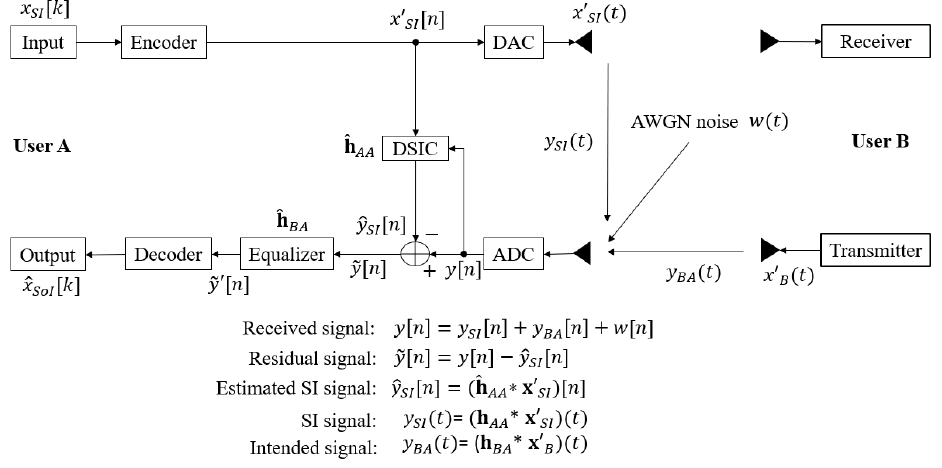
Figure 1. SISO FD transmission with the SB_DSICED3_W/OF